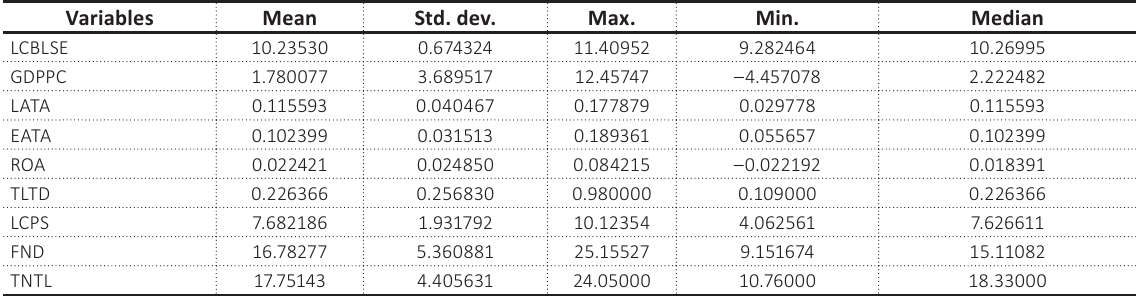
Table 2. List of variables and descriptive statistics